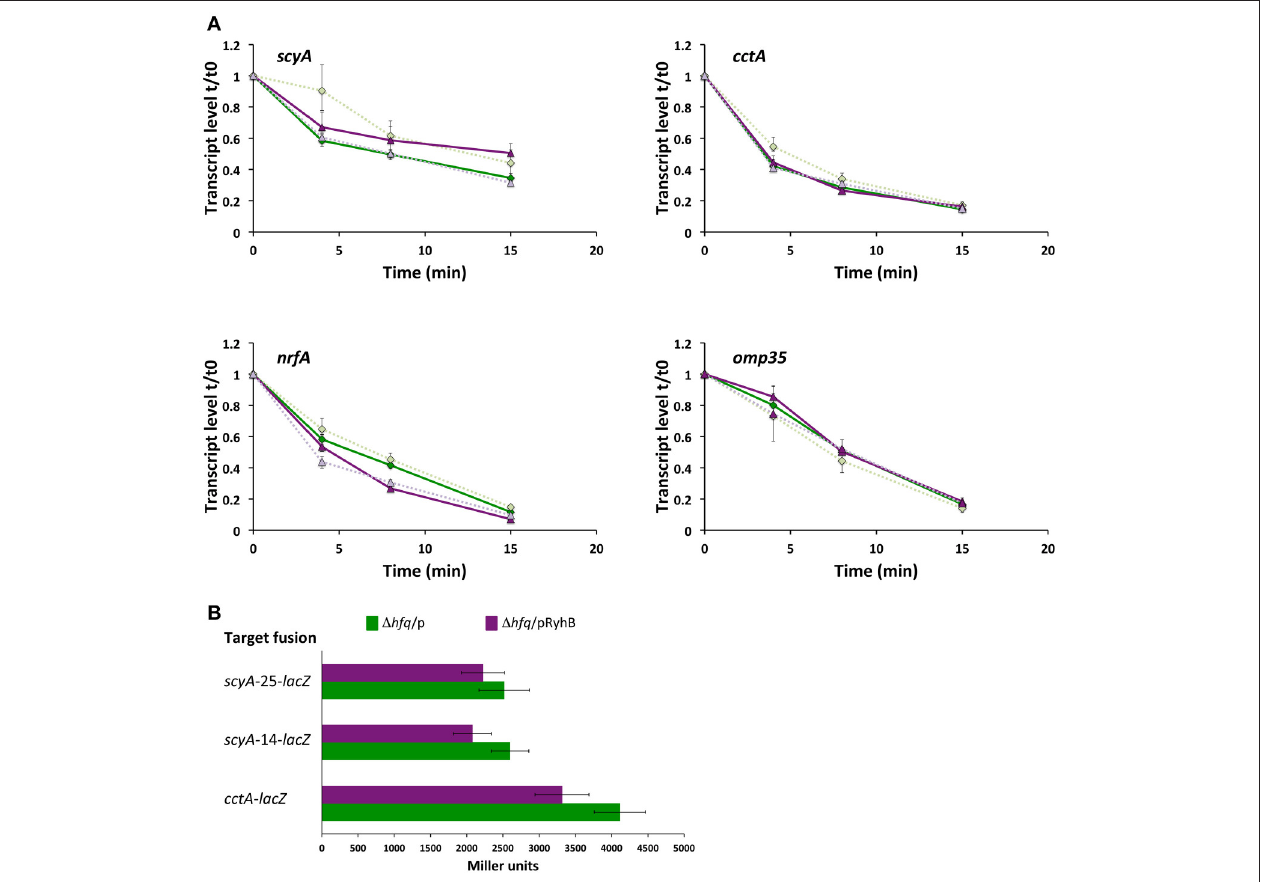
FIGURE 5 | Hfq is required for regulation of RyhB targets. (A) Transcript levels of scyA , cctA , nrfA , and omp35 genes at 0, 4, 8, and 15min after transcription was stopped in a 1 hfq mutant containing an empty plasmid (pKM033) (green diamonds) or a plasmid expressing RyhB (pKM033-ryhB) (purple triangles). qRT-PCR was used to determine the transcript level relative to time 0, just before addition of rifampicin. Data are from two experiments; each with four replicate cDNA samples used in qPCR and shown as expression ratio ± standard error. For both strains, data from experiment 2 are depicted in lighter color and using a dashed line. (B) Activity of plasmid encoded target gene fusions in the 1 hfq mutant expressing RyhB (from pKM033-RyhB; pRyhB) or containing an empty plasmid (pKM033; p). Activities are shown as the mean (Miller units) ± SD and are the data from two independent experiments, each with duplicate cultures, and triplicate